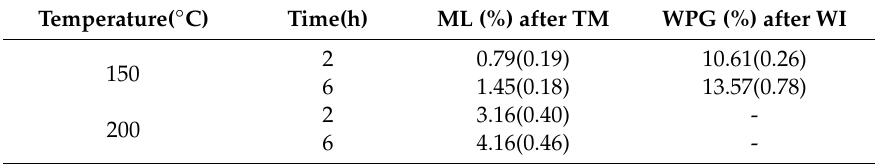
Note: - means no wax